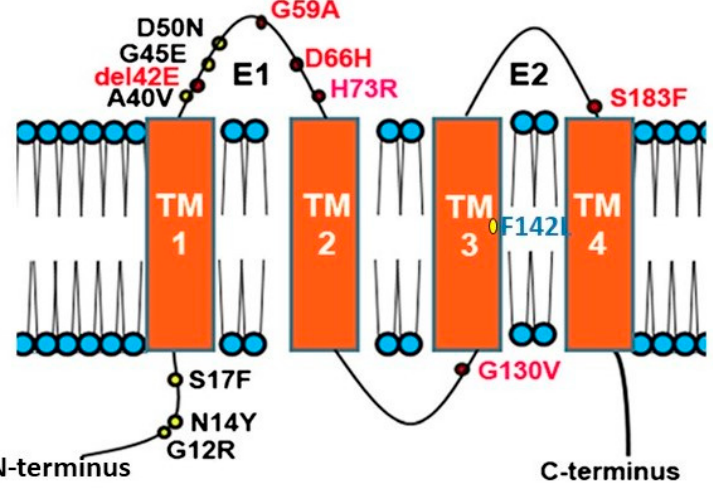
Figure 1. Topology of Connexin 26 and examples of mutations in CX26 associated with epidermal dysplasia and hearing loss. N amino terminus; E1 extracellular loop 1; E2 extracellular loop 2; TM transmembrane domain . Mutations in red indicate ‘Class 2 ′ black, ‘Class 3 ′ and blue ‘Class 4 ′ mutations (see Section 2.2).